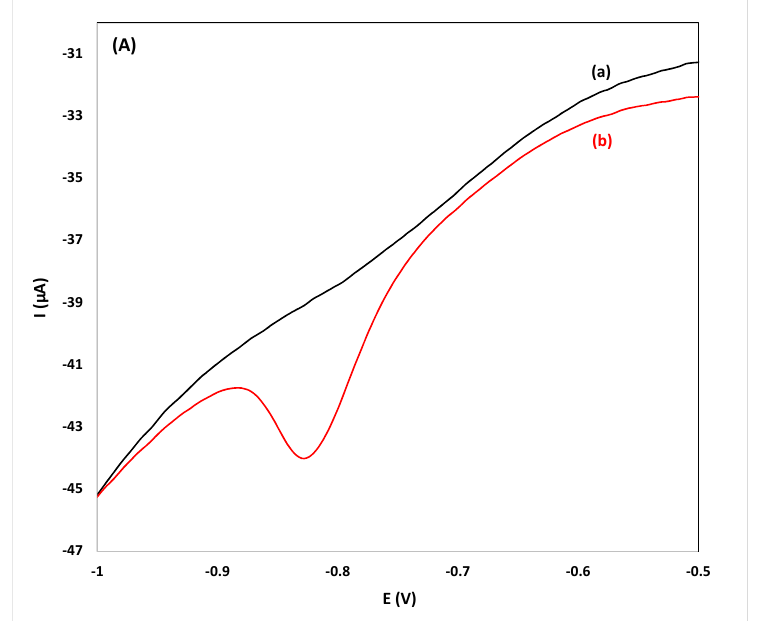
Table 2. Accuracy for the determination of flunitrazepam in individual spirits using the reduction peak R 2